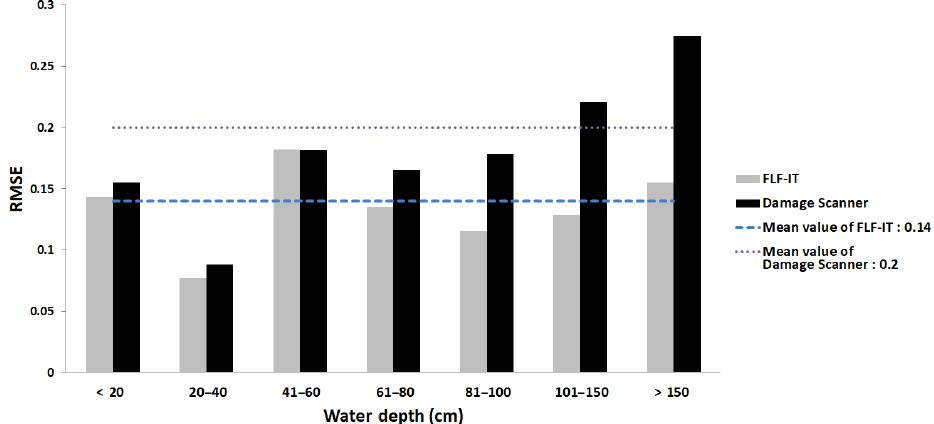
Figure 6. Comparison of the flood damage estimation models’ precision per water-depth class (RMSE: root mean square error; number of samples for each sub-class of water depth, respectively, is 14, 36, 52, 96, 125, 222, and 68).